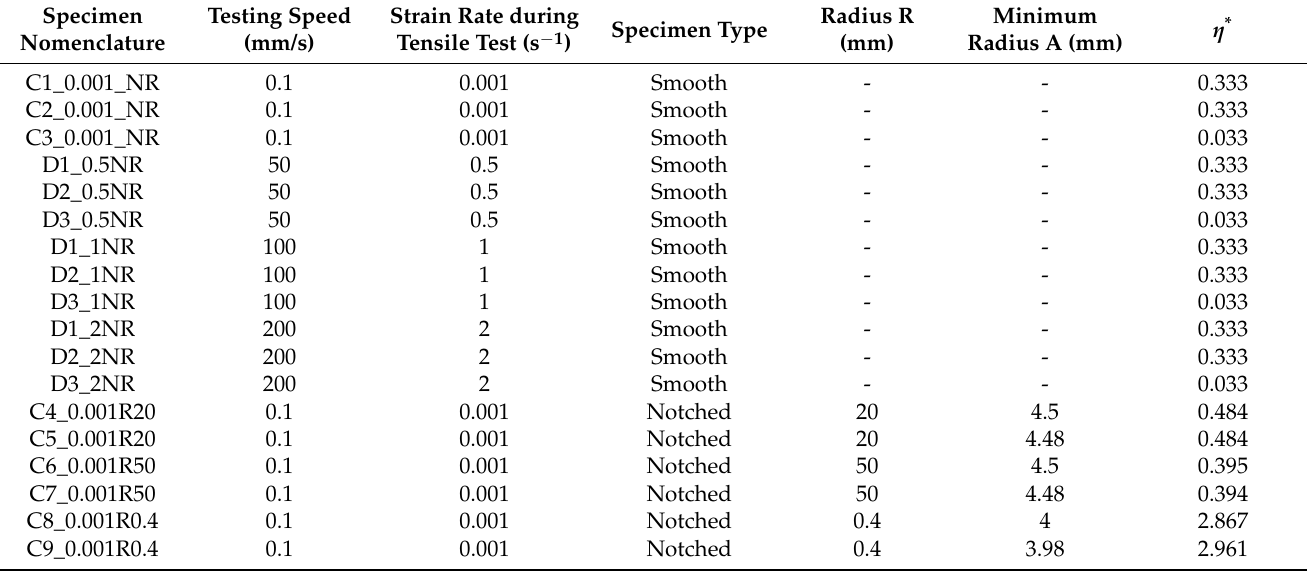
Figure 5. Detailed specimen fixture mechanism. Table 2. Manufactured specimen specifications and testing parameters (C—static; D—dynamic _strain rate_notch